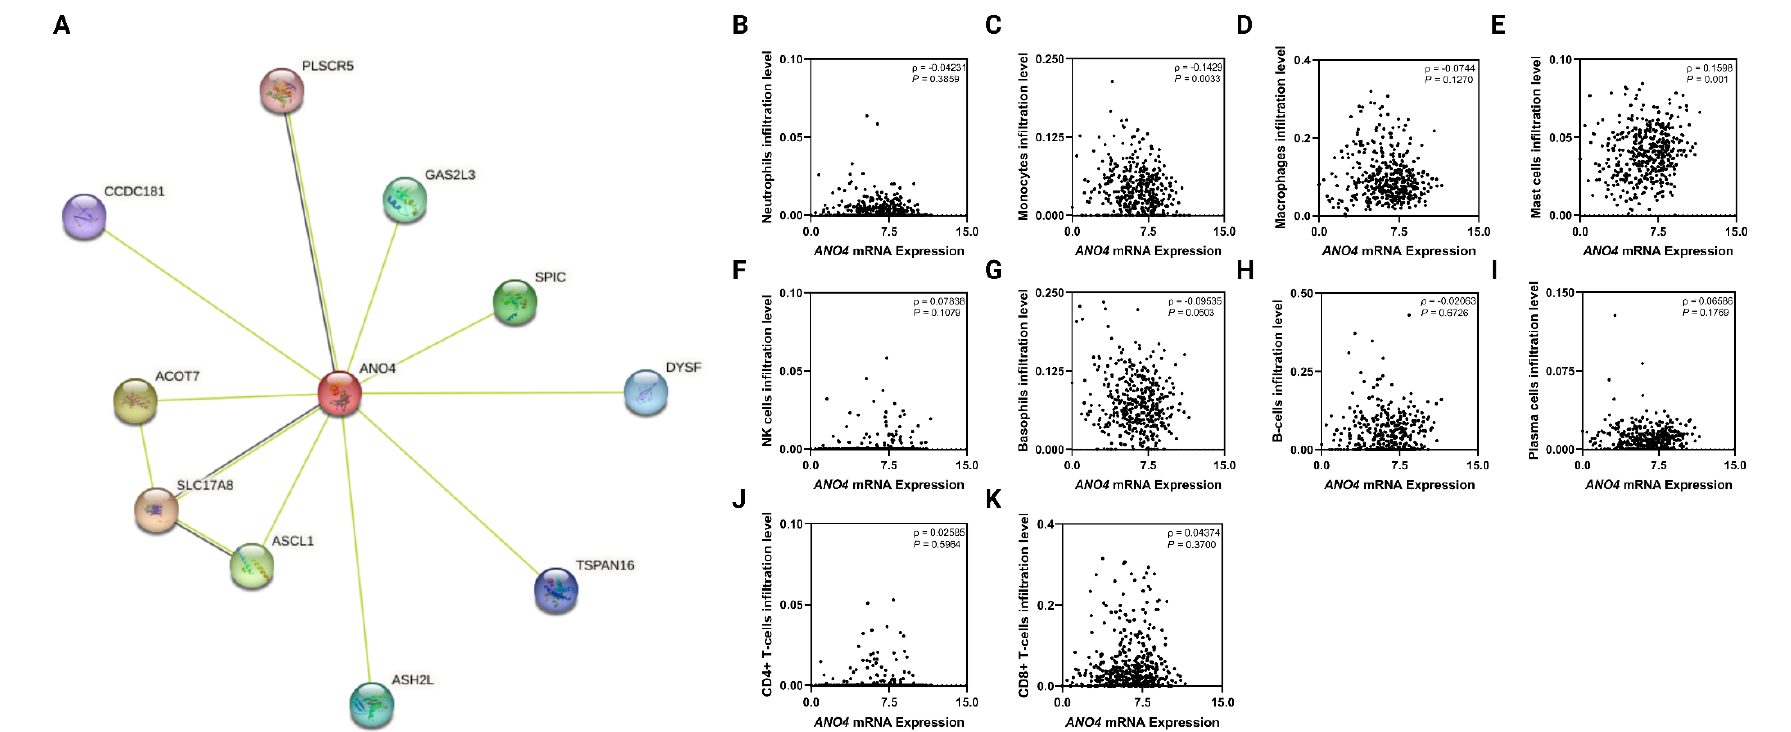
Figure 5. PPI network of ANO4 based on string analysis ( A ). The correlation between ANO4 expression and immune microenvironment ( B – K ).